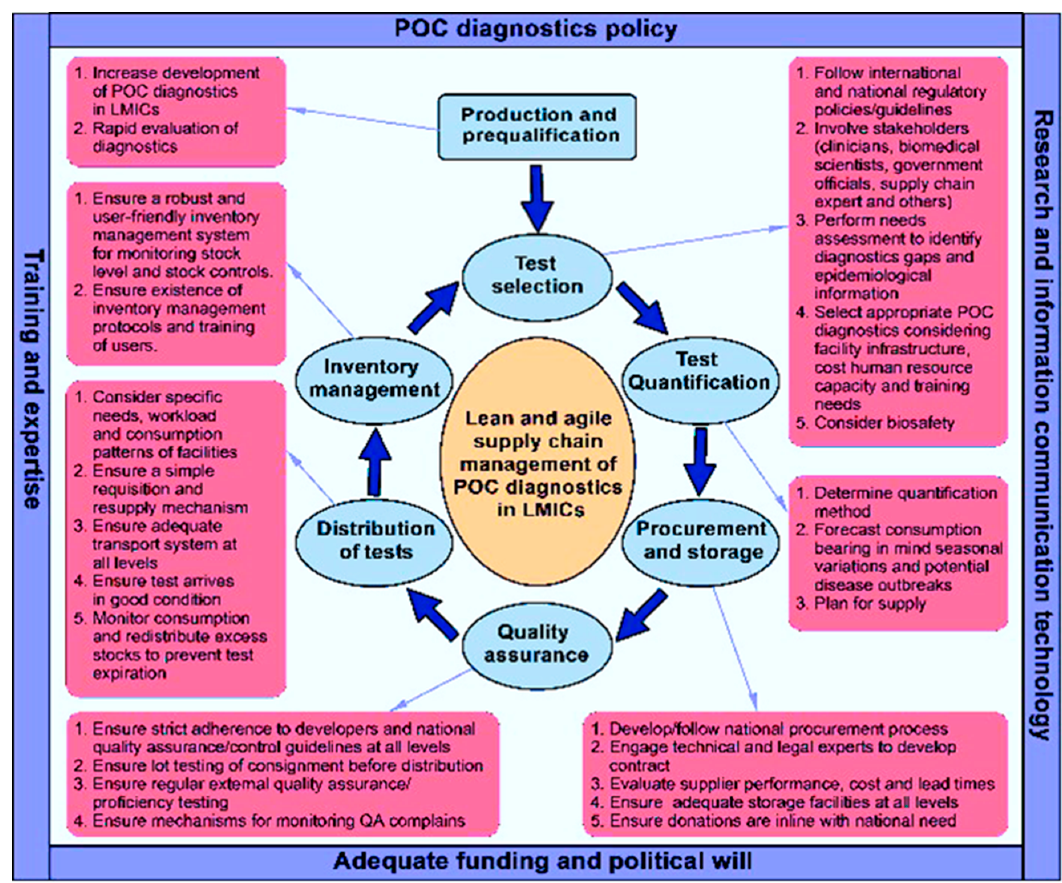
Figure 1. Lean and agile supply chain management framework for improving access to POC diagnostics services in LMICs.